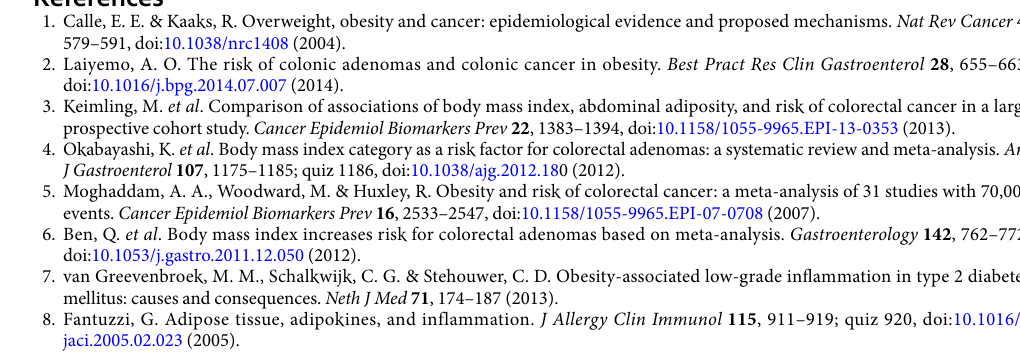
unanimously show the influence of BMI on low-grade systemic inflammation and adenoma, but not vice versa 4, 38, 39 . Colorectal adenoma cases in our study were not pathologically verified, and single measurement of plasma CRP may not have completely represented random variation within the subjects. Incorporating additional steps to reduce this possibility could have led to a further increase in the reliability of our results. Finally, as previously mentioned 23 , it is important to note that the present study was based on prevalent cases instead of incident cases, which suggests that the ORs in this study cannot necessarily be applied to infer the risk of adenoma “develop- ment”. Rather, they can only imply the risk of “having” an adenoma at a given time point, and should thus be interpreted carefully. In summary, this study in a middle-aged and elderly Japanese population showed a positive association between plasma CRP level and colorectal adenoma, notably in larger and multiple adenomas. However, the posi- tive association was attenuated after adjustment for BMI, which likely suggests that plasma CRP level was largely